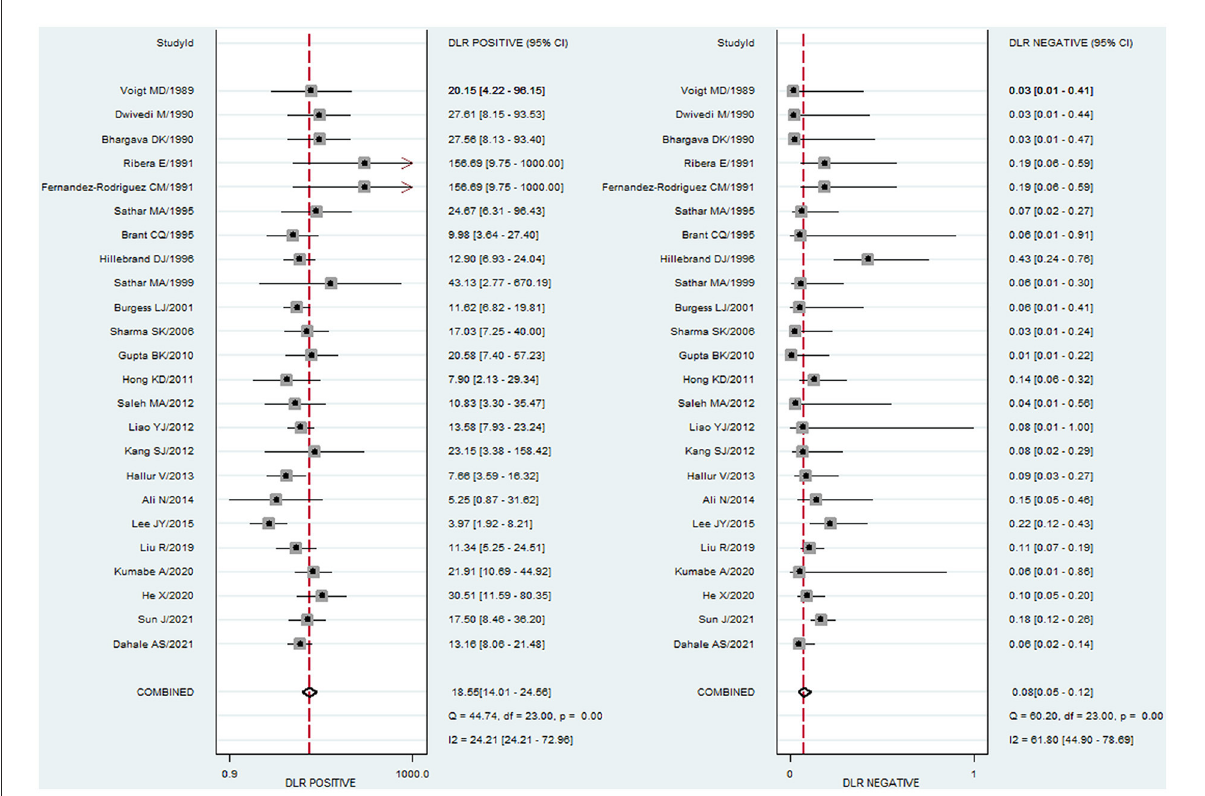
FIGURE4 Paired forest plots of combined PLR and NLR of ADA for the diagnosis of abdominal TB. PLR and NLR in each study were represented by squares, and 95% confidence intervals were represented by horizontal